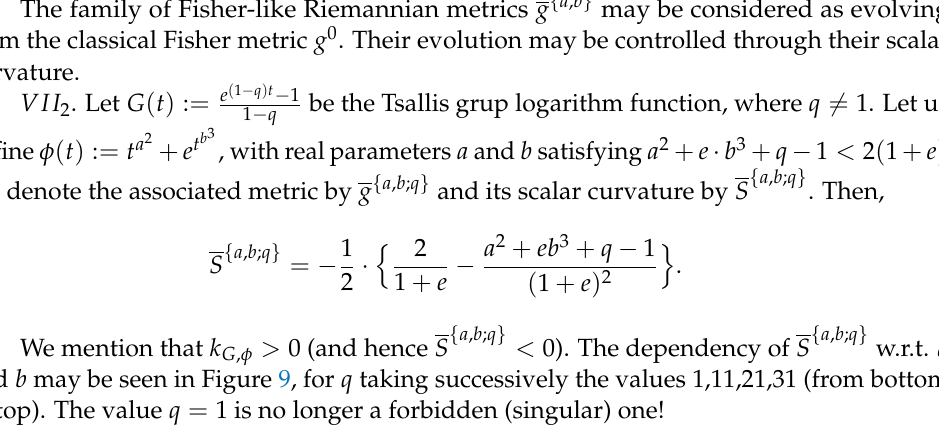
{ a , b } w.r.t. a and b